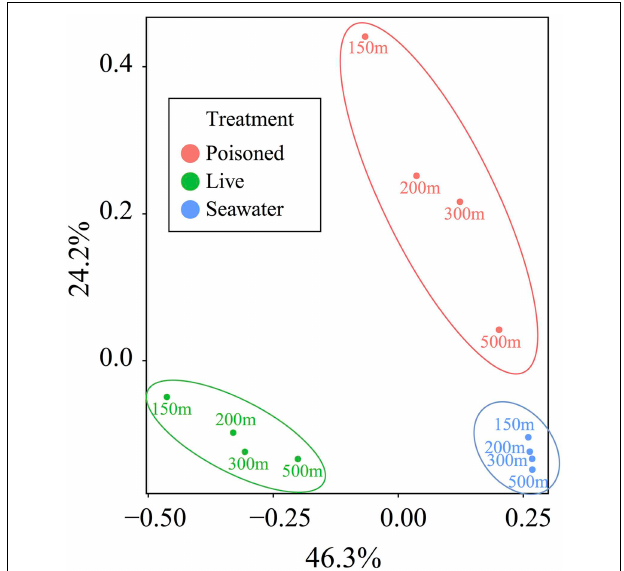
FIGURE 3 | Principal coordinate analysis of the relative abundance of taxa, as determined by protein-coding genes, in live particle, poisoned particle, and seawater samples. Samples were grouped into significant clusters according to treatment, as assessed by non-parametric analysis of variance based on dissimilarities ( p < 0 . 001